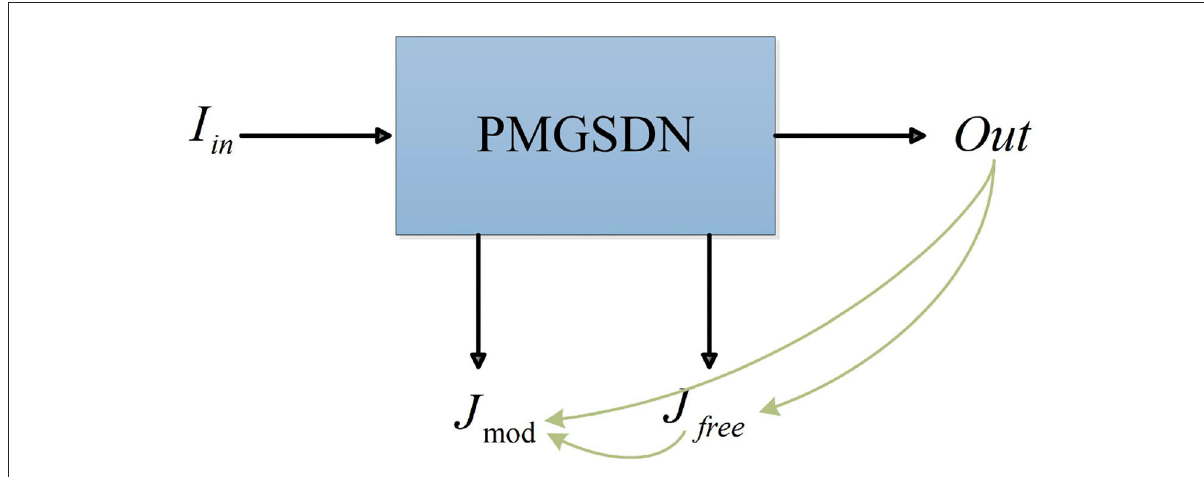
TheconvolutionandpoolingusedinAGFEBareexpressedasConv1toConv7andPool1toPool3fromlefttorightandtoptobottom.Noticethatthekernelsizeoftheadaptiveaverage